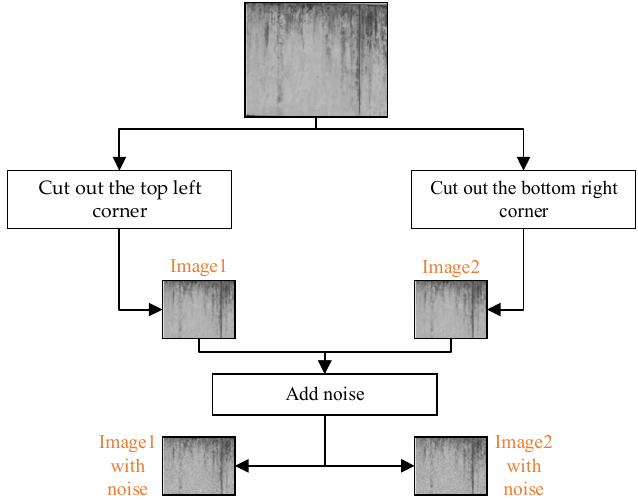
Figure 7. The workflow of gain simulation experiment data.